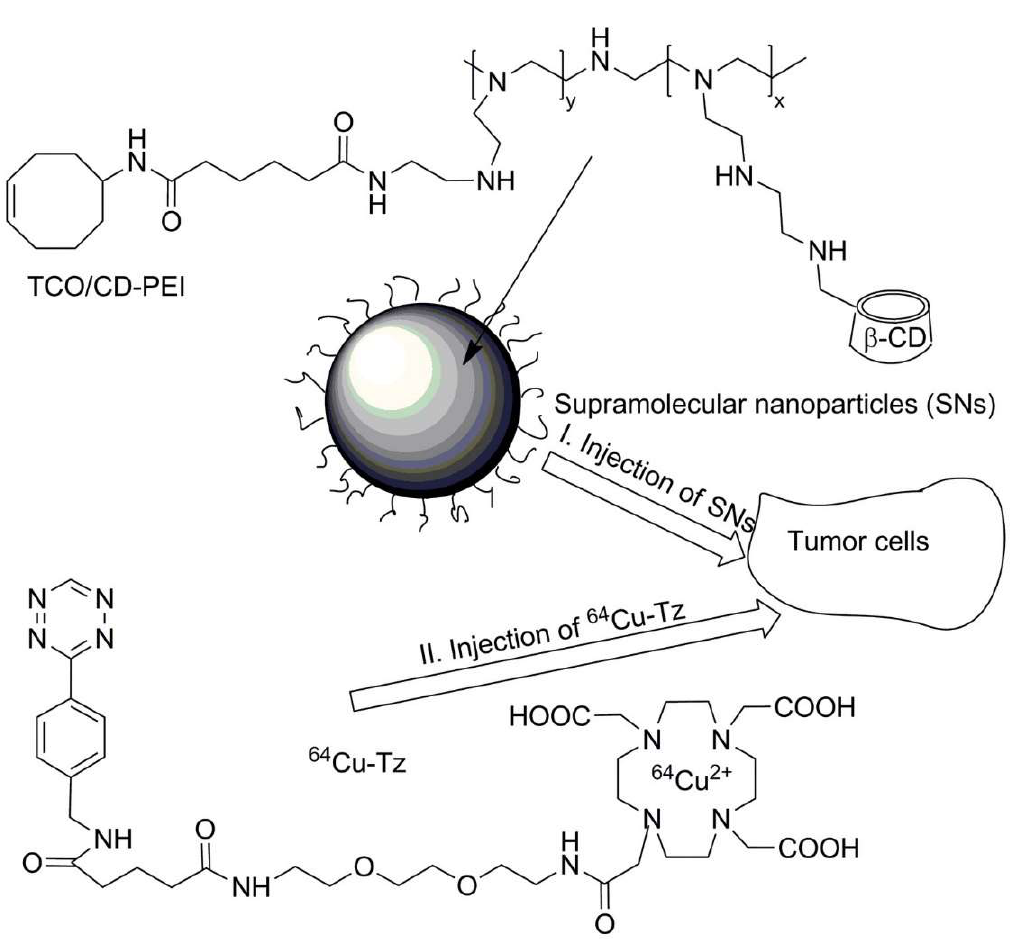
Table 2. Examples of particles carrying attached ligand(s) binding to receptors of targeted cells. Type (Material) of Particle Attached Ligand